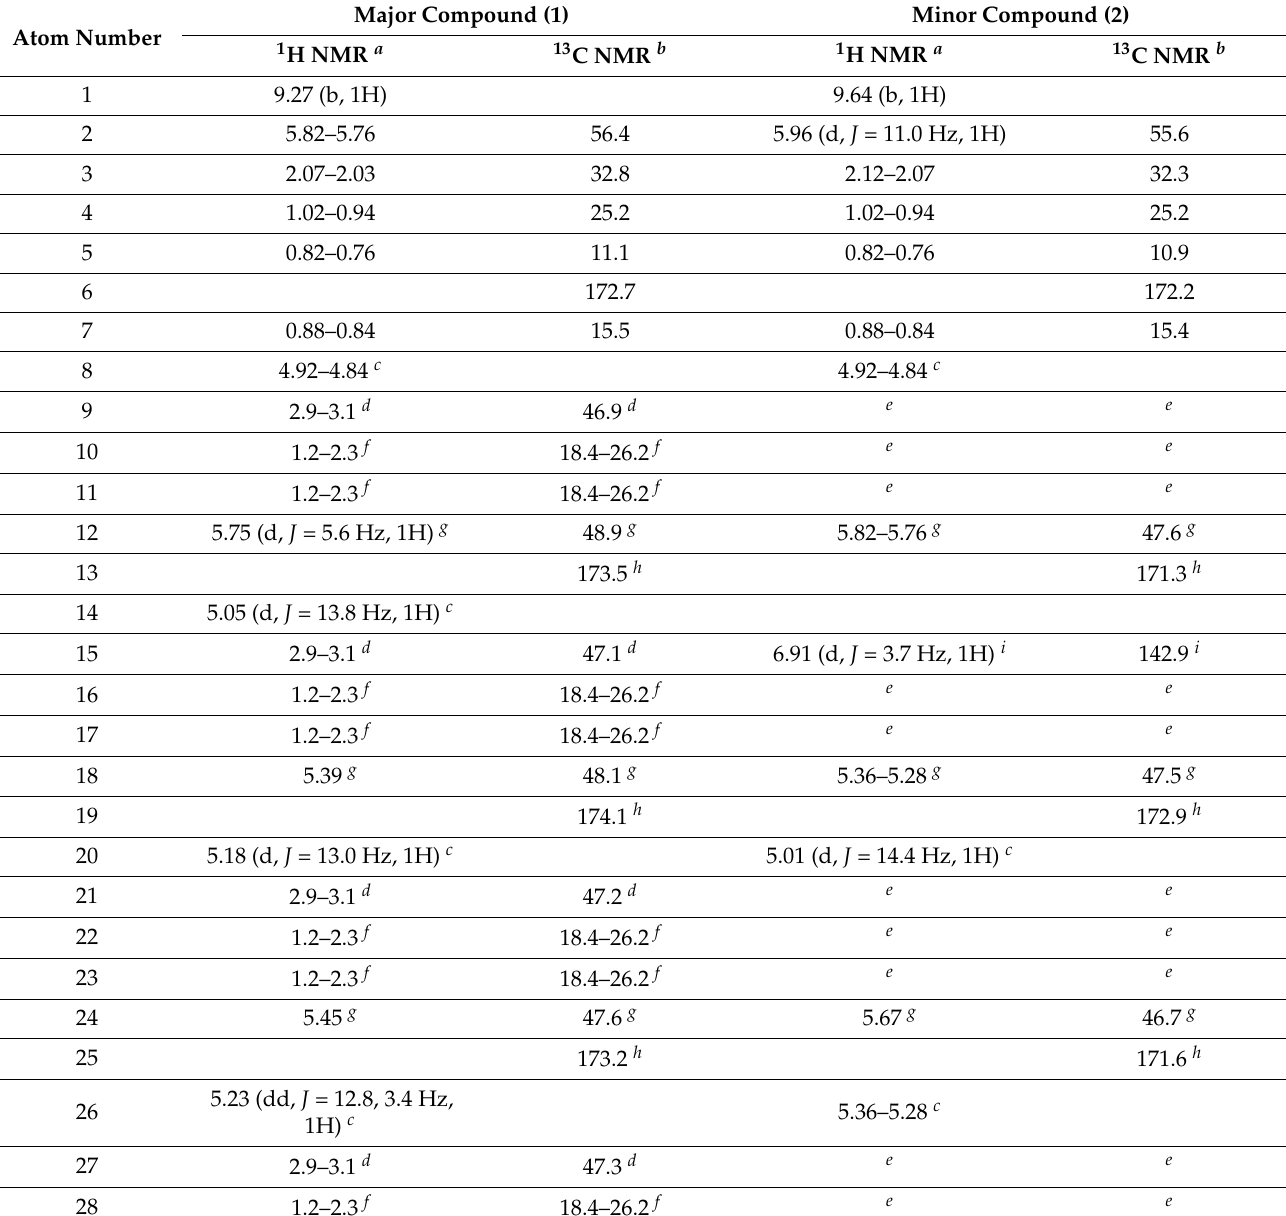
Table 2. Assignment of NMR signals of the major ( 1 ) and minor ( 2 ) components of the semi puri- fied